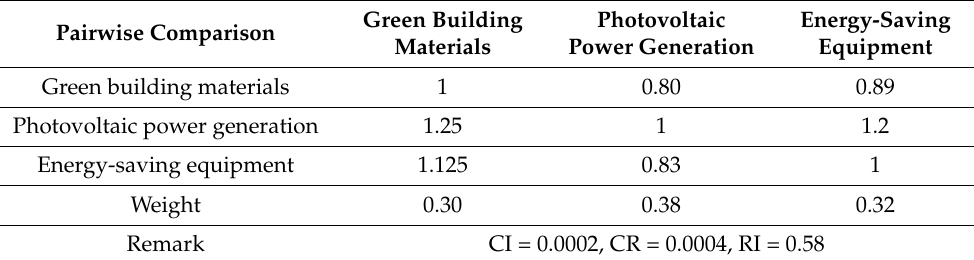
Table 3. Pairwise comparison of relative weights of factors at level 2-1.